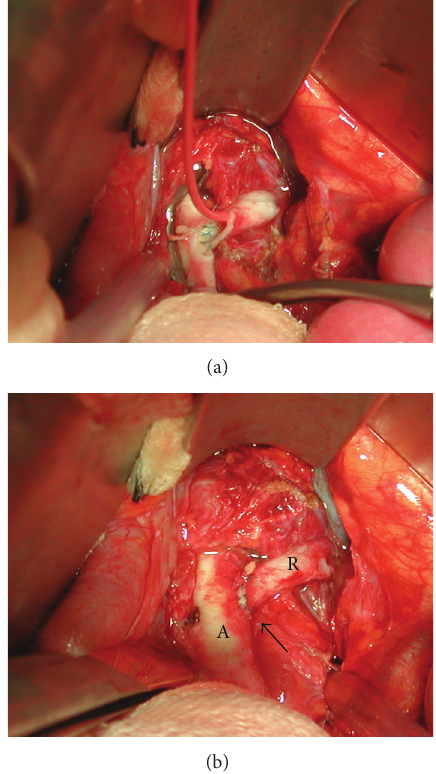
Figure 2: (a) Intraoperative view of renal cooling through 4Fr catheter during construction of aortorenal anastomosis after exci- sion of the stenotic lesion. (b) Intraoperative view of completed reimplantation of left renal artery (R) in the aorta (A) after excision of stenosis. Arrow indicates end-to-side anastomosis.